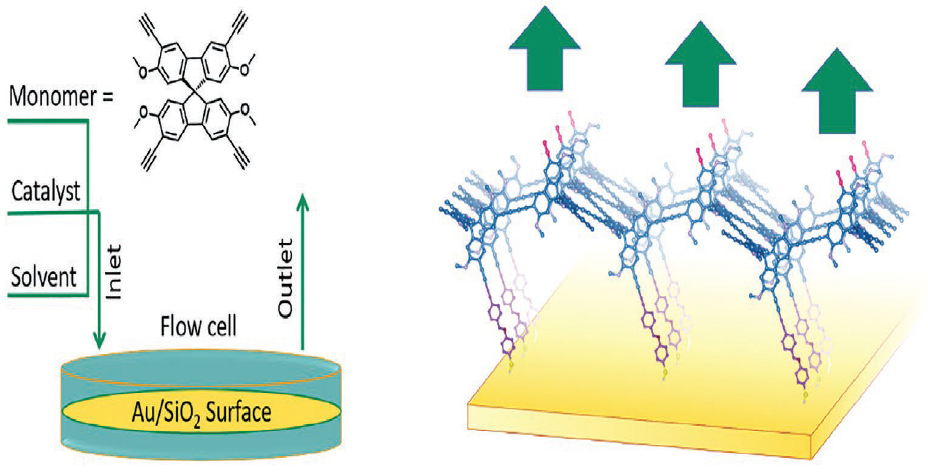
Figure 2. Synthesis of 3D COF films by continuous flow method [32].